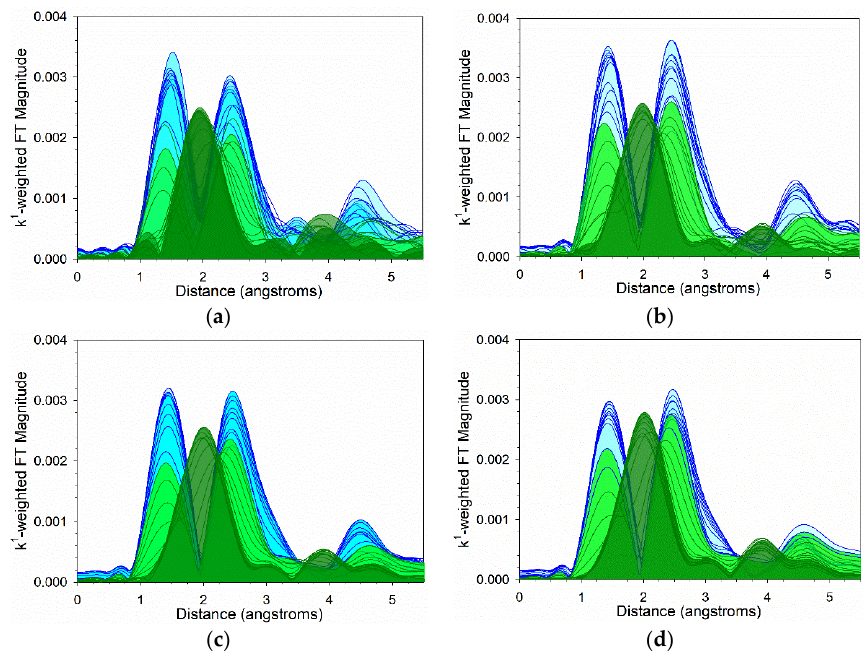
Figure 16. H 2 -TPR-EXAFS spectra at the Ni K-edges of ( a ) 25%M (M = 5%Ni-95%Co)/Al 2 O 3 , ( b ) 25%M (M = 10%Ni-90%Co)/Al 2 O 3 , ( c ) 25%M (M = 25%Ni-75%Co)/Al 2 O 3 , and ( d ) 25%M (M = 50%Ni-50%Co)/Al 2 O 3 . (Cyan) is Ni 2+ (e.g., NiO) associated with cobalt oxides during reduction of Co 3 O 4 to CoO. (Green) is reduction of Ni 2+ to Ni 0 when NiO reduction is associated with CoO reduction to Co 0 .